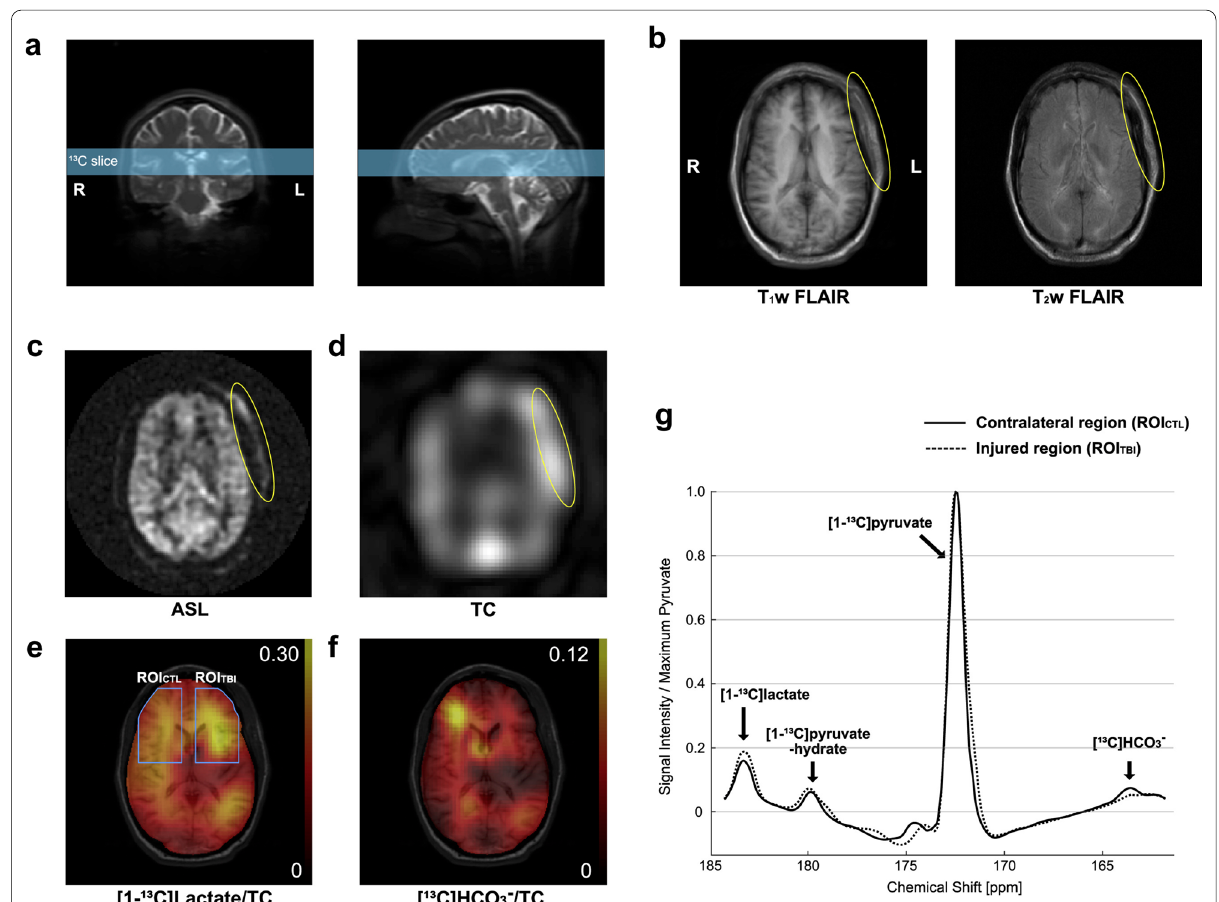
Fig. 2 Metabolism of acute traumatic brain injury (TBI) imaged by hyperpolarized 13C-pyruvate. The patient (35 years old, male), injured on the left frontal scalp, was imaged 28 h after the injury. a An axial slice that includes the injured region was prescribed for 13C imaging. b T1-weighted and T2-weighted 1 H FLAIR and ( c ) ASL images showed swelling and increased perfusion in the injured site outside the skull (yellow circle), whereas no cerebral contusion, hemorrhage or hypoperfusion were detected. d Region with increased total hyperpolarized 13C signal image matched to the scalp edema. e Increased [1-13C]lactate conversion and ( f ) decreased [13C]HCO3 – production were detected in the brain tissues of the injured hemisphere. g Averaged spectra over the injured brain region and the contralateral normal-appearing brain region. Reproduced with